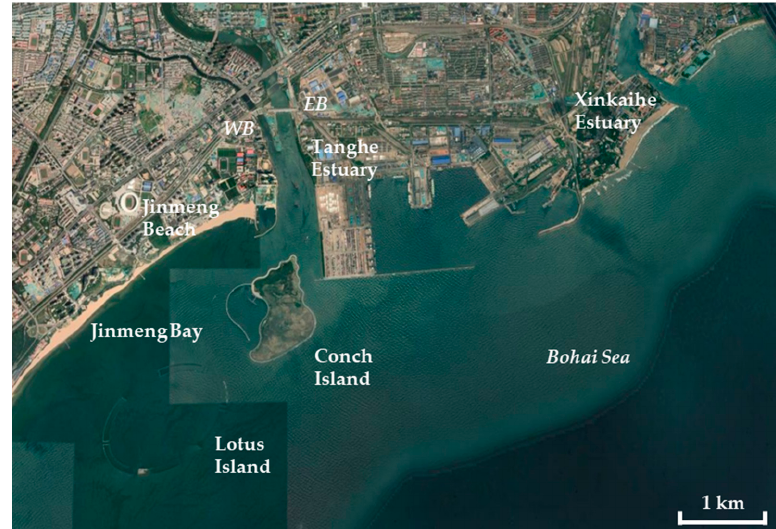
Figure 2. Site map of the study area in Jinmeng